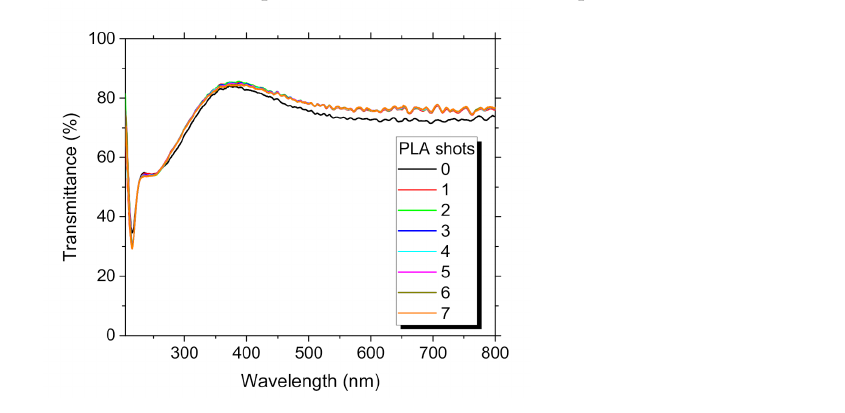
Figure 10. Emission spectra of Lu 2 O 3 :Eu thin film, dependence on the number of PLA shots.